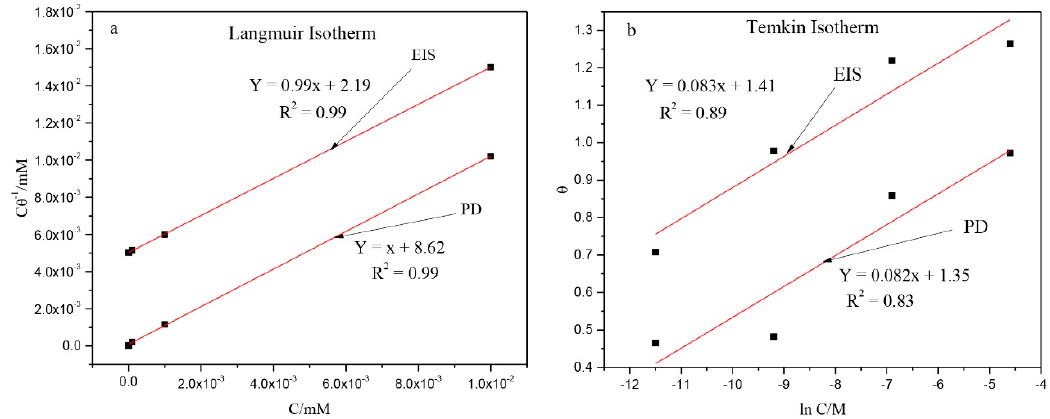
Figure 4. Langmuir ( a ) and Tamkin ( b ) adsorption plots of Cu5Z5Al1Sn alloy in 3.5 wt.% NaCl in the presence of the addition of different concentrations of cysteine obtained by EIS and PD experiments.